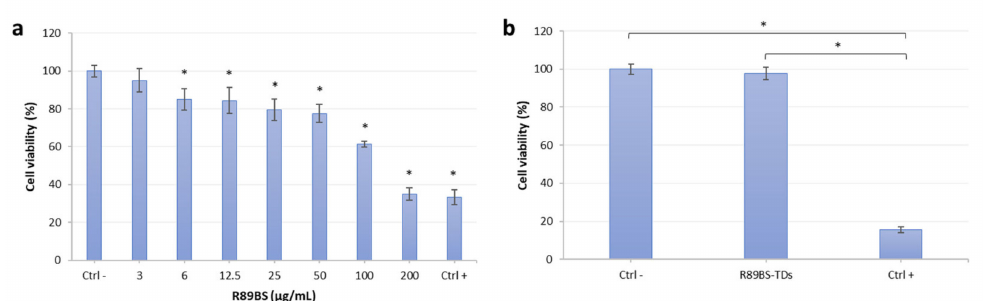
Figure 4. Results of the eucaryotic cell viability MTT test: ( a ) hOBs viability data with R89BS added as aqueous solution at concentrations ranging from 200 to 0 µ g/mL (Ctrl − ); ( b ) Viability data obtained from hOBs cultured in the eluate from R89BS-coated discs (R89BS-TDs) and uncoated titanium discs (Ctrl − ). Triton X-100 was used as positive control (Ctrl +). Error bars represent standard deviations. (* p <